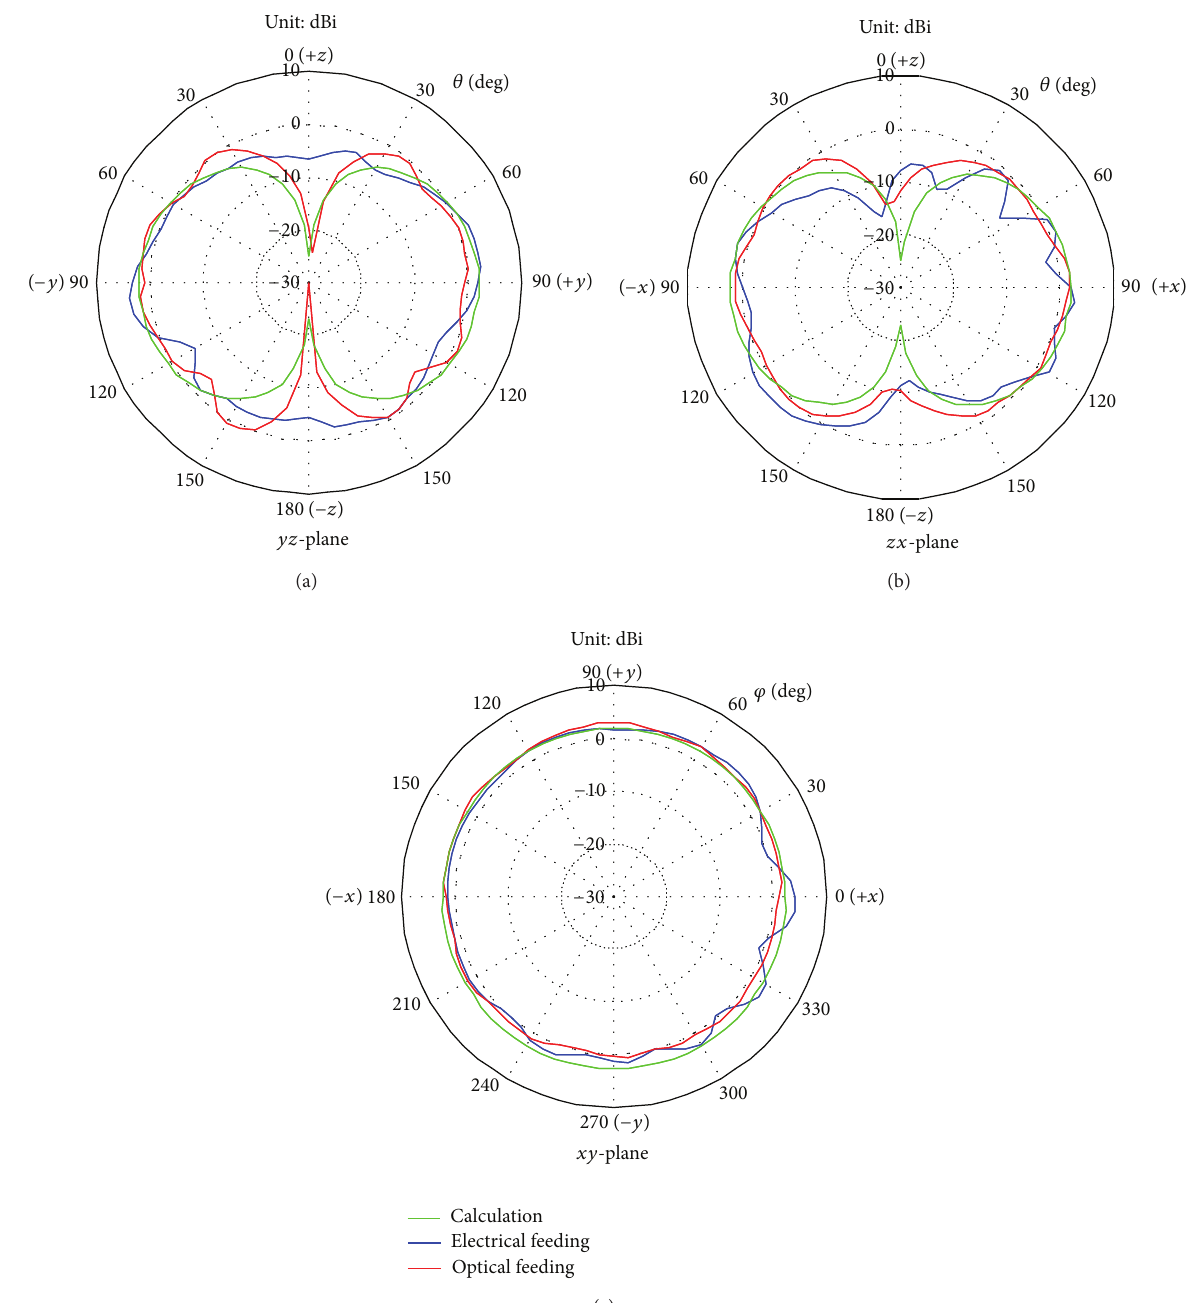
Figure 10: Measured and calculated radiation patterns for total field at